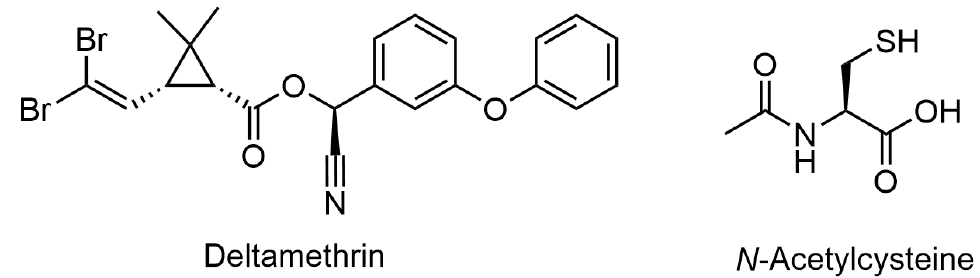
Figure 1. Chemical structures of deltamethrin and N -acetylcysteine.